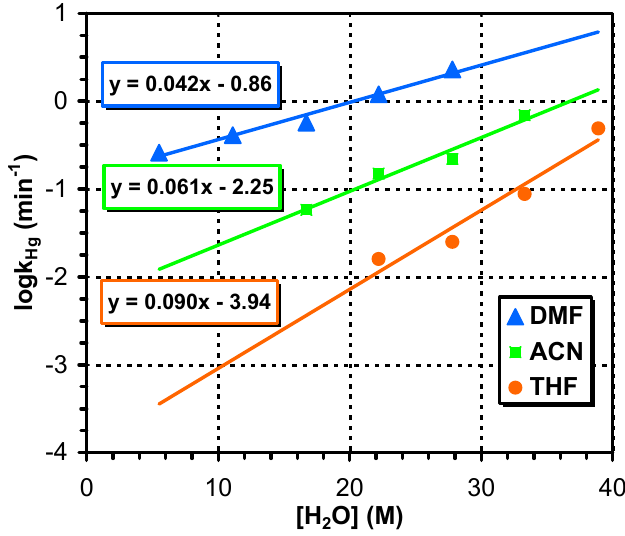
Figure 2. Variation of the logk Hg values with the water concentration for the aprotic co-solvents. Table 1. The pseudo first-order rate coefficients for the reaction of 1,5-ICAN with water and HgCl 2 in different water/aprotic co-solvents mixtures. The errors of the obtained rate coefficients were within ± 10%. Experimental conditions: [1,5-ICAN] = 2.5 × 10 − 6 mol / L, [HgCl T = 25 ◦